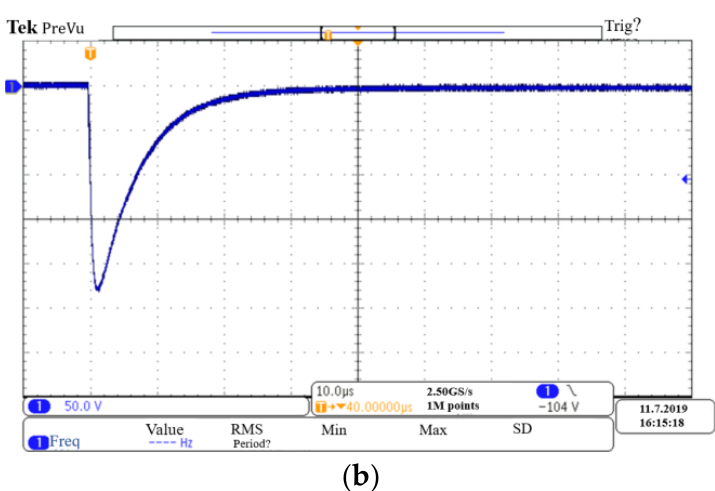
Figure 13. Impulse response waveforms of two multi-coil systems. (a) Single-damped coil system; (b) double-